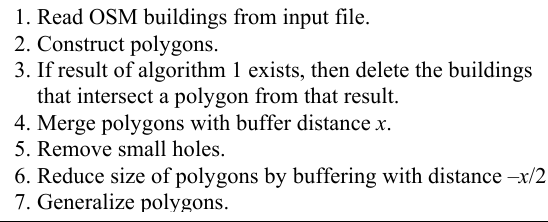
Figure 9. Algorithm 2 for processing OSM buildings